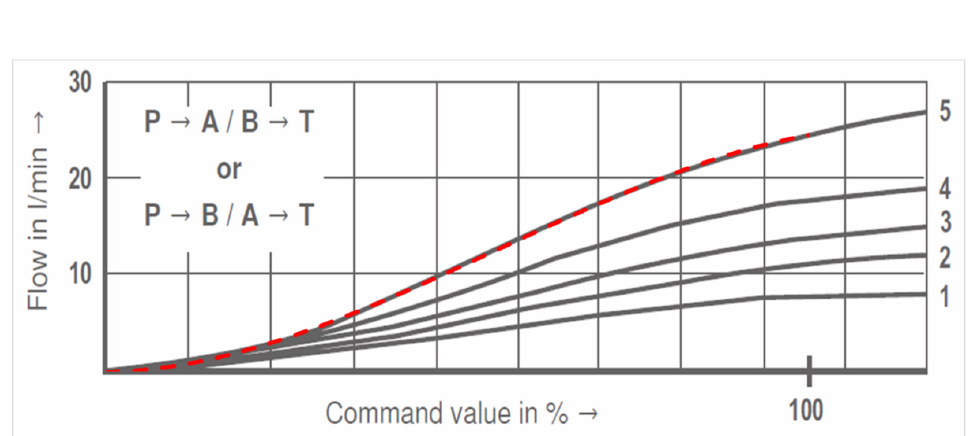
Figure 3. Opening characteristic curve of the spool valve from the data sheet with a fitted curve of model based on Equation (4). Curves 1–5 correspond to different valve pressure differential, the red dashed line is the fitted curve.